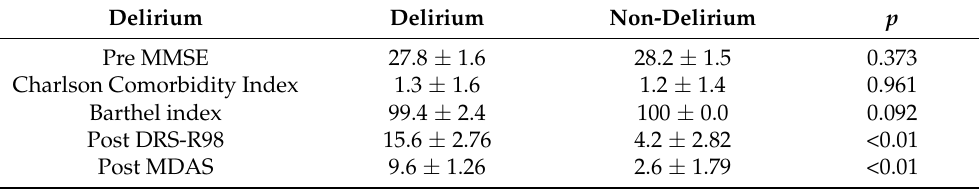
Table 2. Pre- and post-operative clinical measures of the patients. Delirium Delirium Non-Delirium Pre